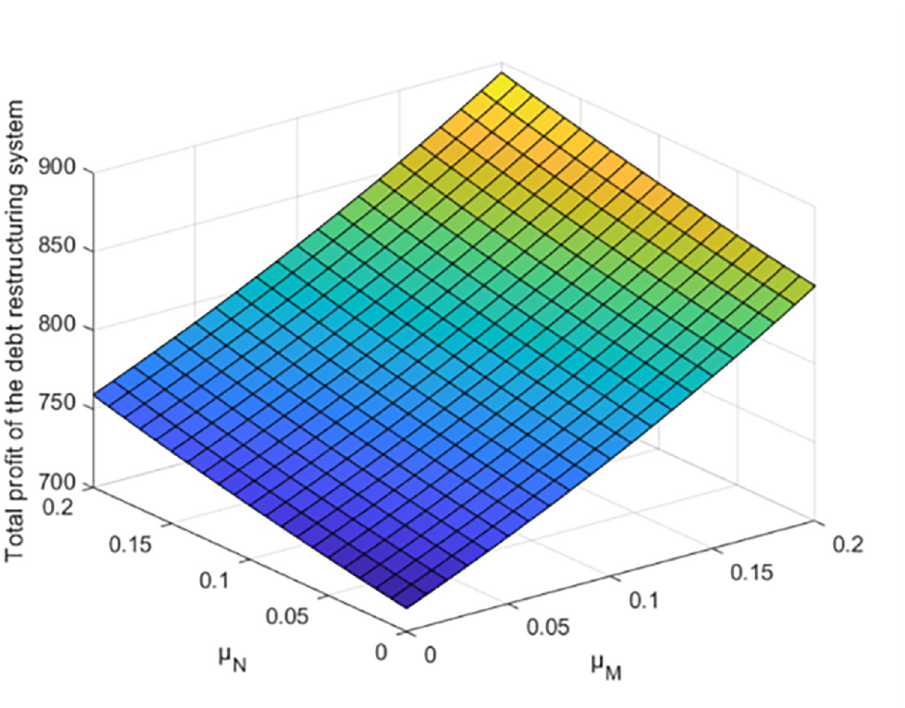
Fig 7. Effect of parameter μ